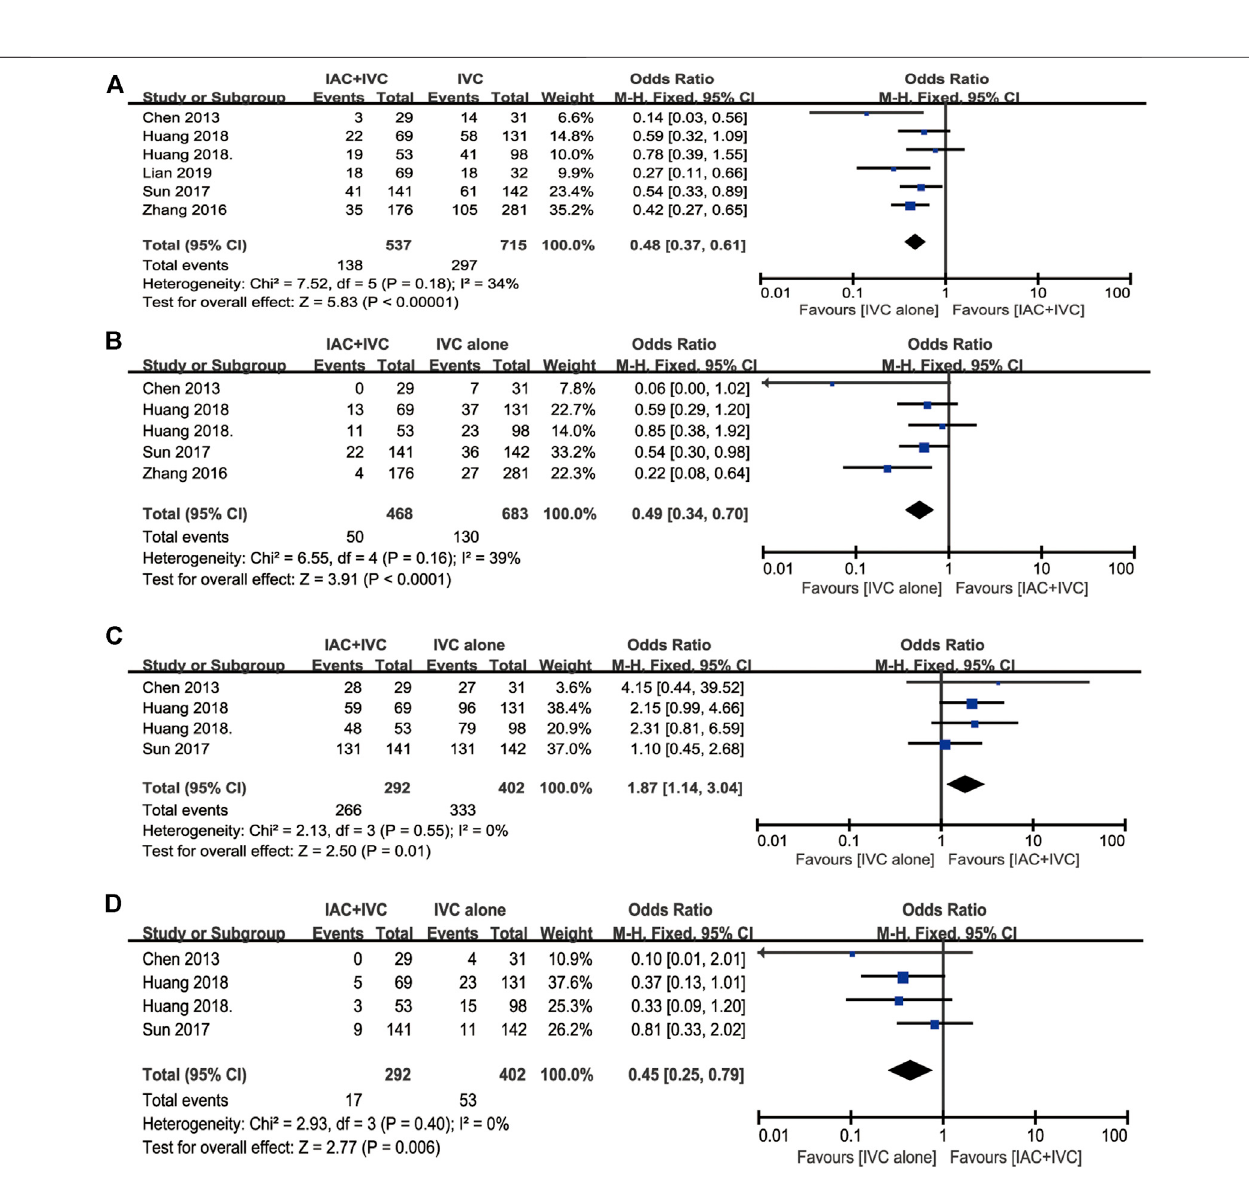
FIGURE 5 | Subgroup analysis for IAC + IVC vs. IVC. (A) tumor recurrence rate, (B) tumor progression rate, (C) survival rate, (D) tumor-speci fi c death rate.